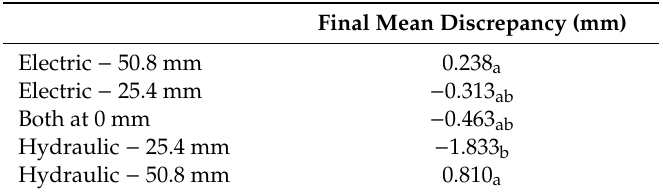
Table 4. LSD comparison of final discrepancy between the electric and hydraulic actuator starting from the maximum stroke, while blocking for field.